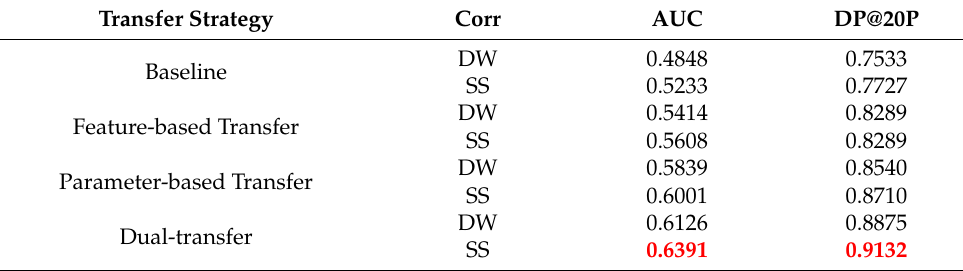
Table 1. Ablation study of our proposed tracker on HS